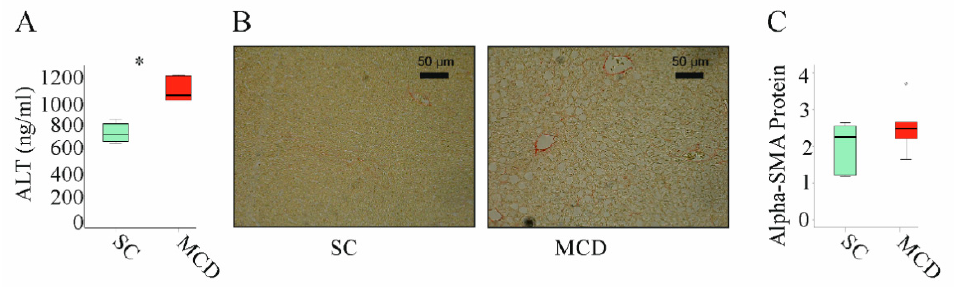
Figure 3. Two weeks of an MCD diet induced serum alanine aminotransferase (ALT) and liver steatosis but not liver fibrosis: ( A ) ALT measured in the serum of mice fed standard chow (SC) or an methionine–choline deficient (MCD) diet for 2 weeks; ( B ) Sirius-red-stained liver of mice fed an SC or an MCD diet for 2 weeks; ( C ) Alpha-smooth muscle actin (alpha-SMA) protein in the liver of mice fed an SC or an MCD diet for 2 weeks ( n = 4–5 mice per group). Mann–Whitney U test, * p < 0.05. Outliers = values between 1.5 and 3 times the interquartile range are shown as circles.